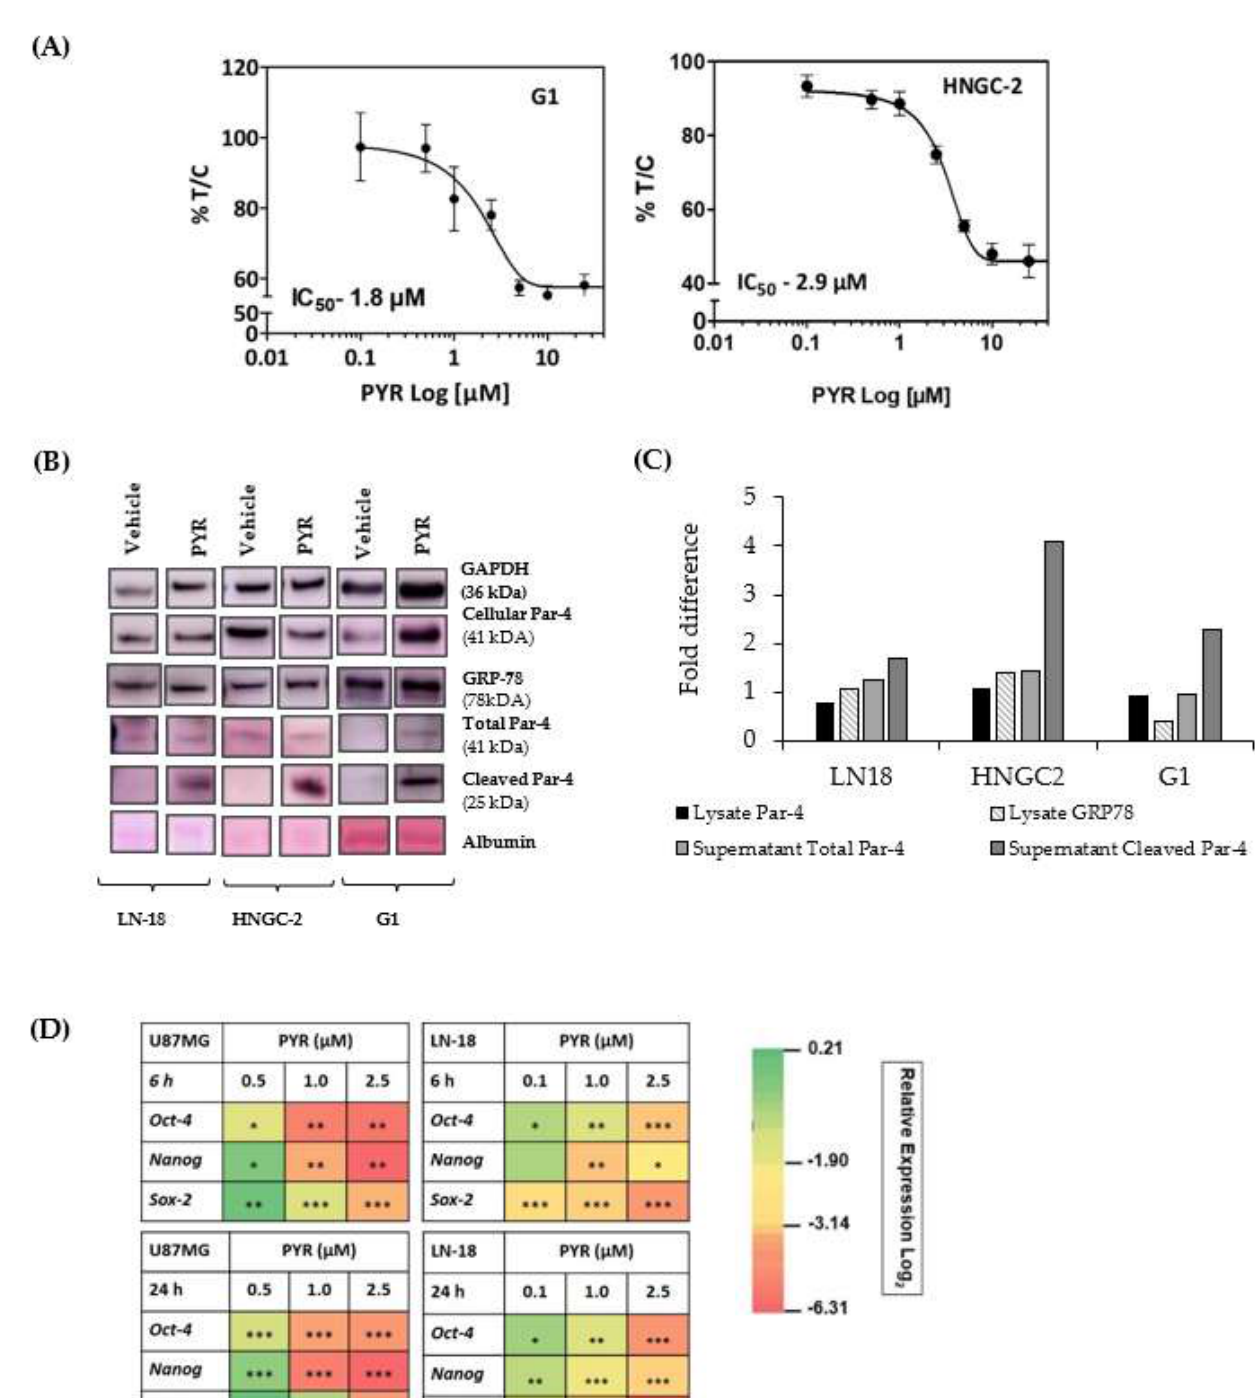
Figure 8. ( A ) Anti-proliferative activity of PYR in highly tumorigenic glioma stem-like G1 and HNCG-2 cells at 72 h. ( B , C ) PYR (25 µM) was tested for its ability to upregulate intracellular Par-4, secretory Par-4, and GRP-78 in three GBM cell lines. WB was done with cell lysates for assessing the expression of intracellular Par-4 and GRP-78 while secretory Par-4 was measured in supernatants of cells treated with the test compounds for 24 h. Untreated cells and DMSO-treated cells served as controls and vehicle controls respectively. The intensity of bands was measured by performing densitometric analysis using Image J software. The data was interpreted as a fold change with respect to vehicle control. GAPDH was used as a loading control. ( D ) Heatmap depicts modulation of stem cell markers in U87MG and LN-18 post 6 and 24 h treatment with PYR. The relative expression of genes was calculated with the relative ΔΔCt method, using GAPDH as housekeeping